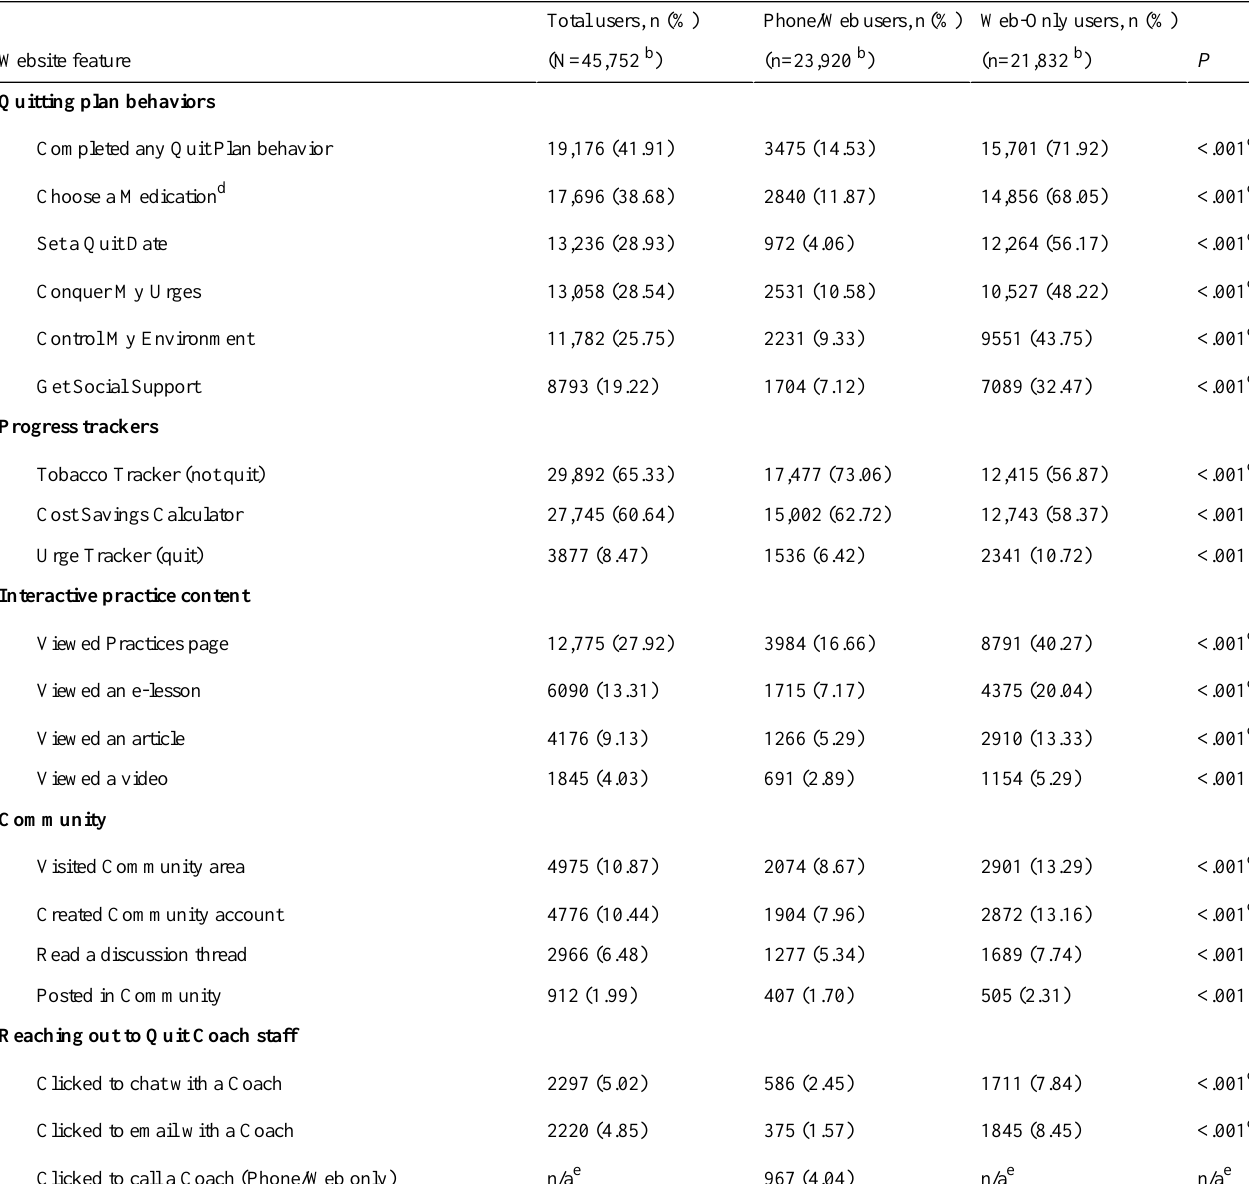
Table 6. Participants using key Web Coach website features among total users and between Phone/Web versus Web-Only users.